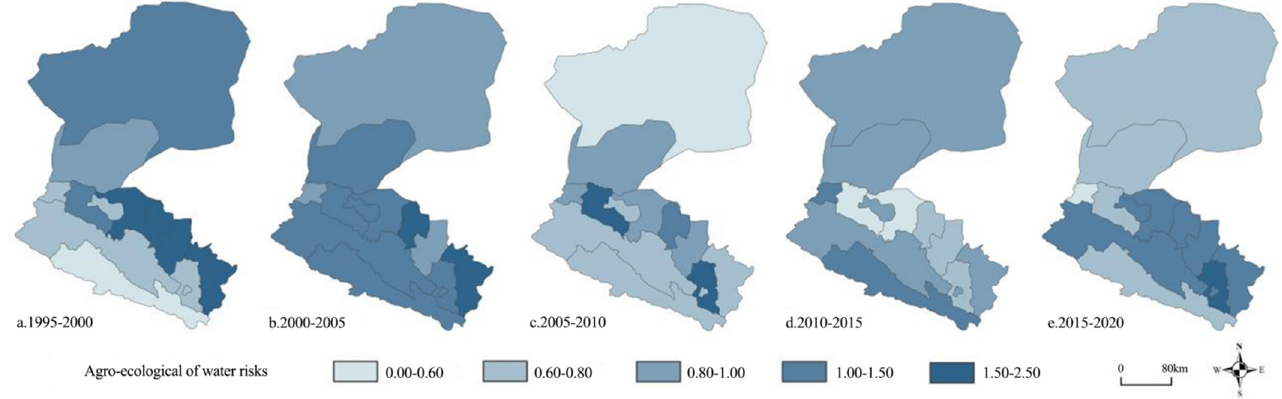
Figure 2. Water risk metric agroecological risk of land by district and county in the HRB over time.